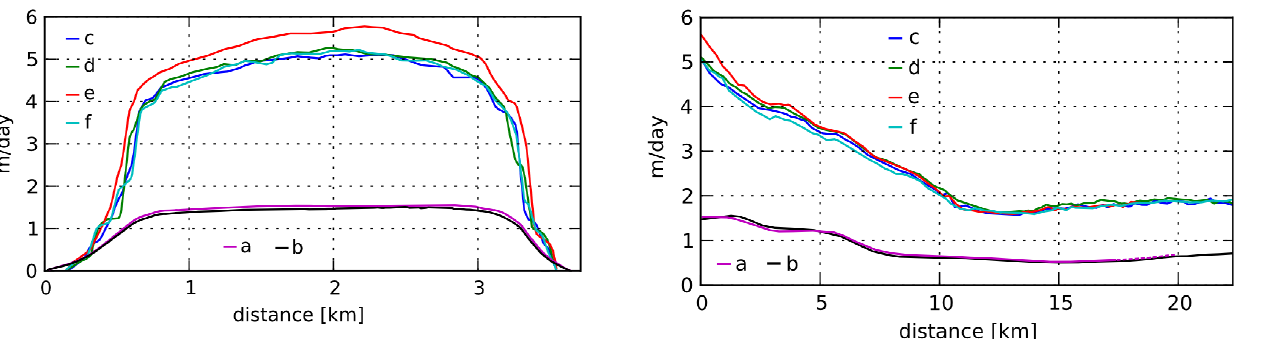
Figure 6. Surface velocity on Crane Glacier at profile C1, derived from ERS InSAR of Dec. 1995 (a), Dec. 1999 (b); from TerraSAR-X of Oct. 2008 (c), Nov. 2008 (d), April 2009 (e), Nov. 2009 (f). Figure 7. Section of TerraSAR-X amplitude image of Crane Glacier terminus, 18 April 2009 (left) and 13 November 2009 (right). The arrow shows the look direction of the radar beam.